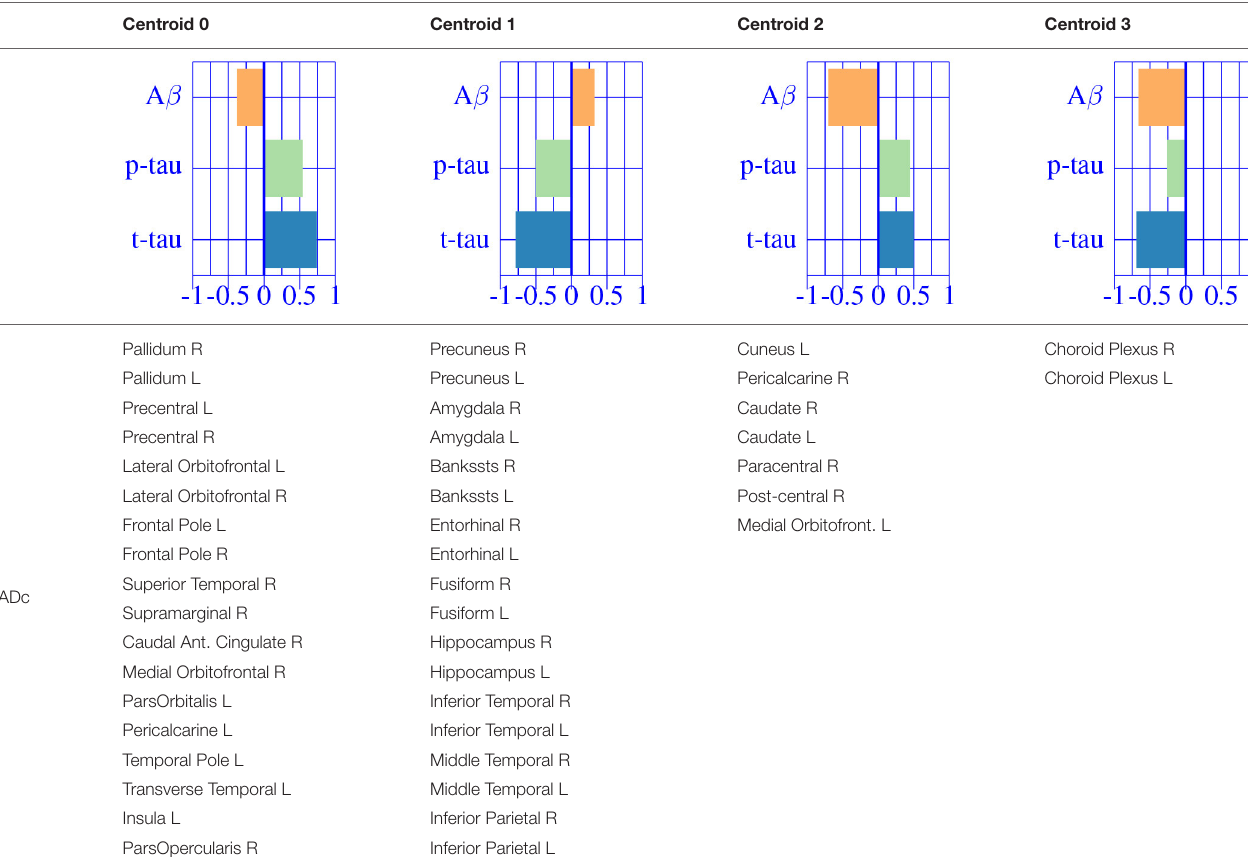
TABLE 2 | Multivariate CSF effects on brain morphology for different diagnostic